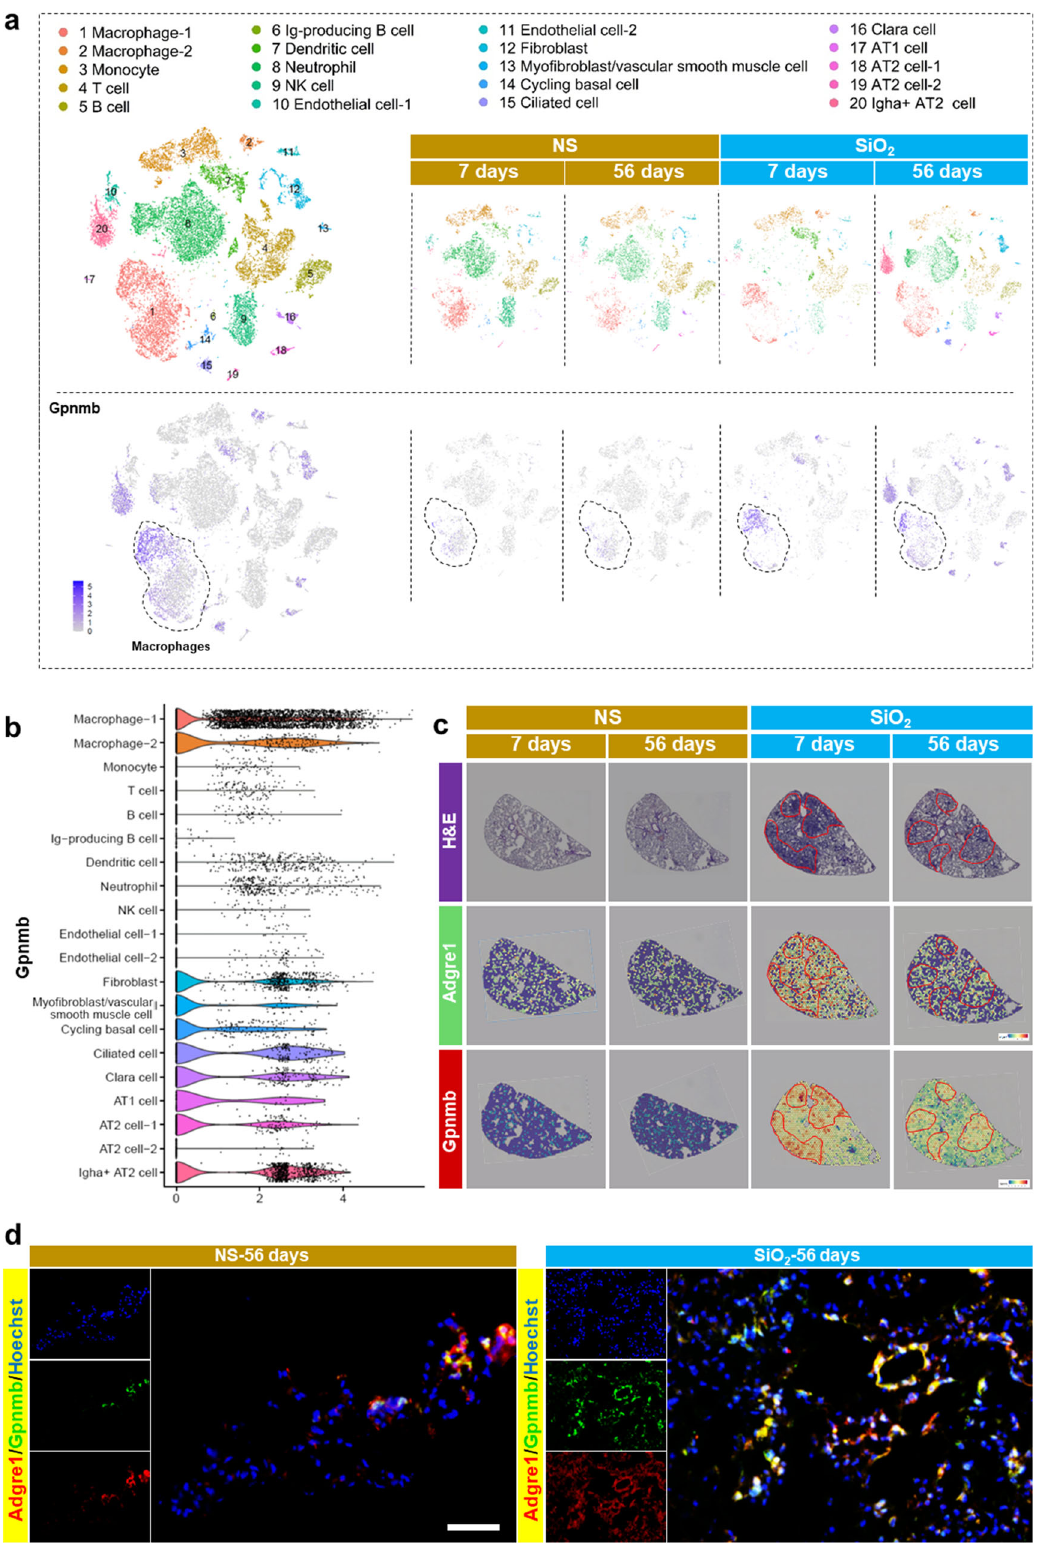
Fig. 4 GPNMB in fi brotic ECM may have been derived from macrophages. a Single-cell clustering and de fi nitions. The cell type for each cluster was annotated according to canonical cell markers in CellMarker. Gpnmb expression in macrophages was increased in SiO 2 -7 day group mice and SiO 2 -56 day group mice. b Expression level of Gpnmbin various cell types. c The expression level of Adgre1 (cell marker of macrophages) and Gpnmb genes in different groups on the spatial plots. d Immuno fl uorescence staining of macrophages and GPNMB in NS-56 day group mice and SiO 2 -56 day group mice; scale bar = 200 μ m. NS, normal